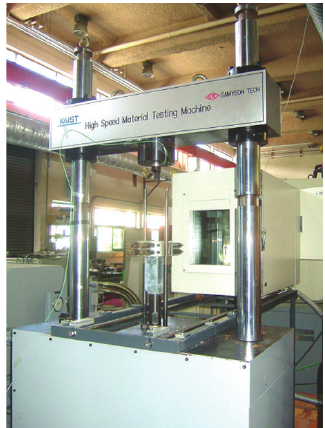
Figure 6: High speed material testing machine.